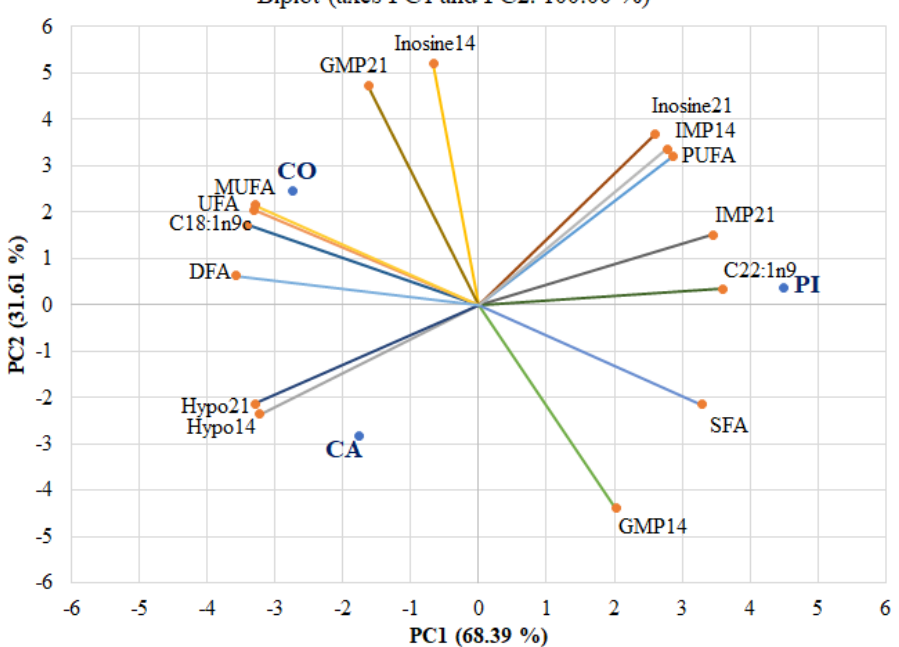
Figure 1. The results of principal component analysis (PCA) of ribonucleotide content and fatty acid composition at different ageing times varied among the different starch sources: CA = ground cassava, CO = ground corn, PI = pineapple stem starch, SFA (saturated fatty acids), MUFA (monounsaturated fatty acids), PUFA (polyunsaturated fatty acids), UFA (unsaturated fatty acids), DFA (desirable fatty acids), Hypo14 or Hypo21 (hypoxanthine content measured at day 14 or 21 post-mortem), inosine14 or inosine21 (inosine content measured on day 14 or 21 post-mortem), IMP14 or IMP21 (inosine monophosphate content measured on day 14 or 21 post-mortem), GMP14 or GMP21 (guanosine monophosphate measured on day 14 or 21 post-mortem).